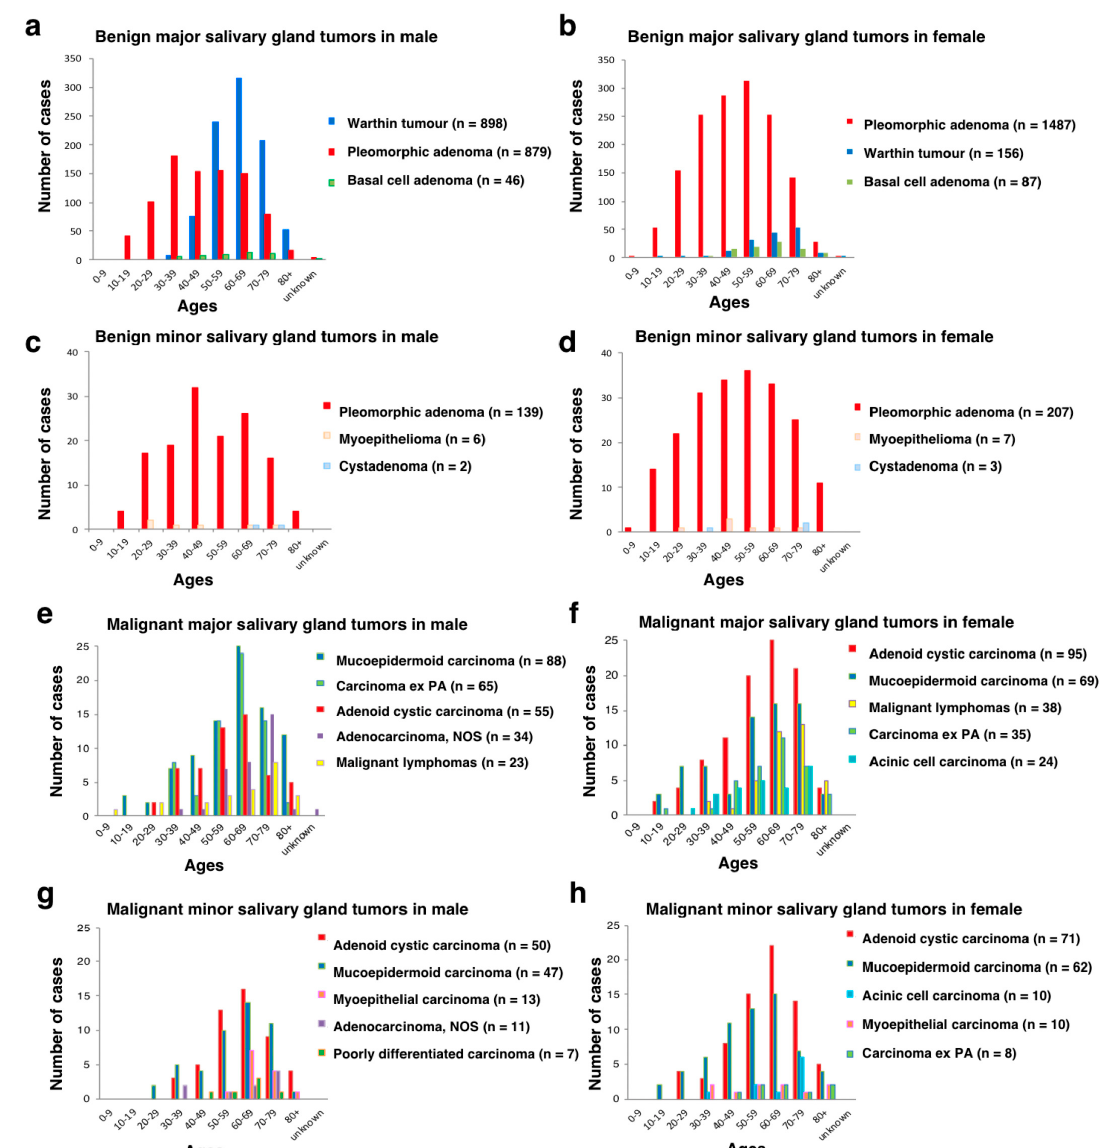
Figure 4. Age distributions of representative histologies in major and minor salivary gland tumors ( a – h ). ( a – d ) benign salivary gland tumors, ( e – h ) malignant salivary gland tumors; NOS: not otherwise specified; PA: pleomorphic adenoma.